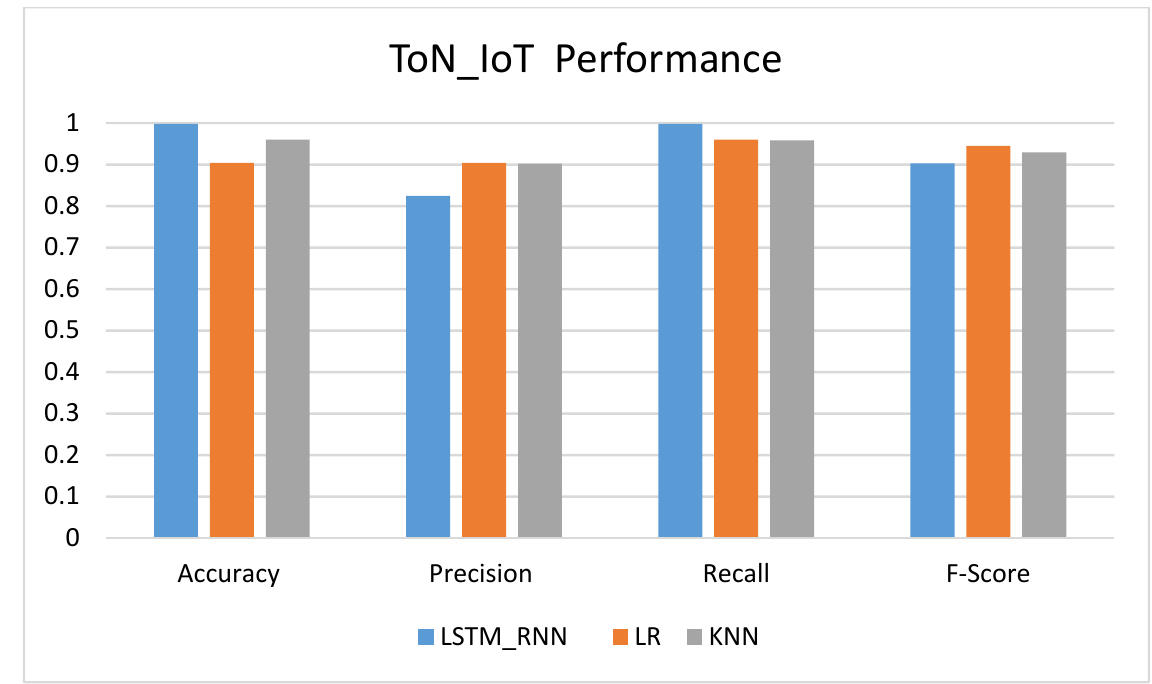
Figure 27. LSTM_RNN Performance Over ToN_IoT Dataset.